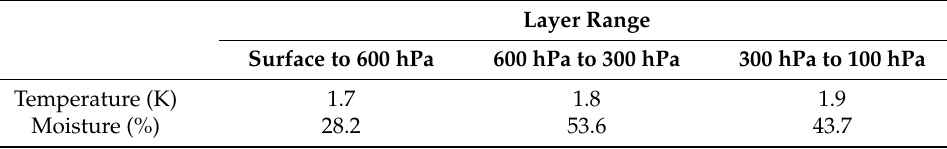
Table 5. The RMSE and bias of the temperature and relative humidity between the retrieval results and ERA5 data in three broad